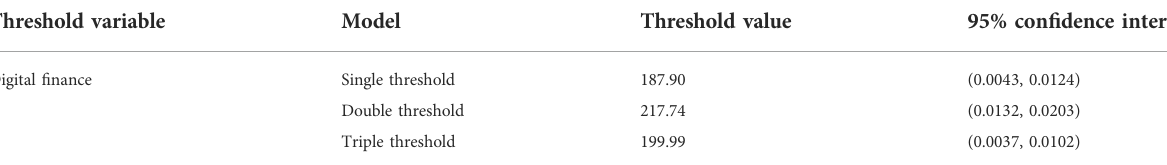
TABLE 10 Result of threshold estimation.